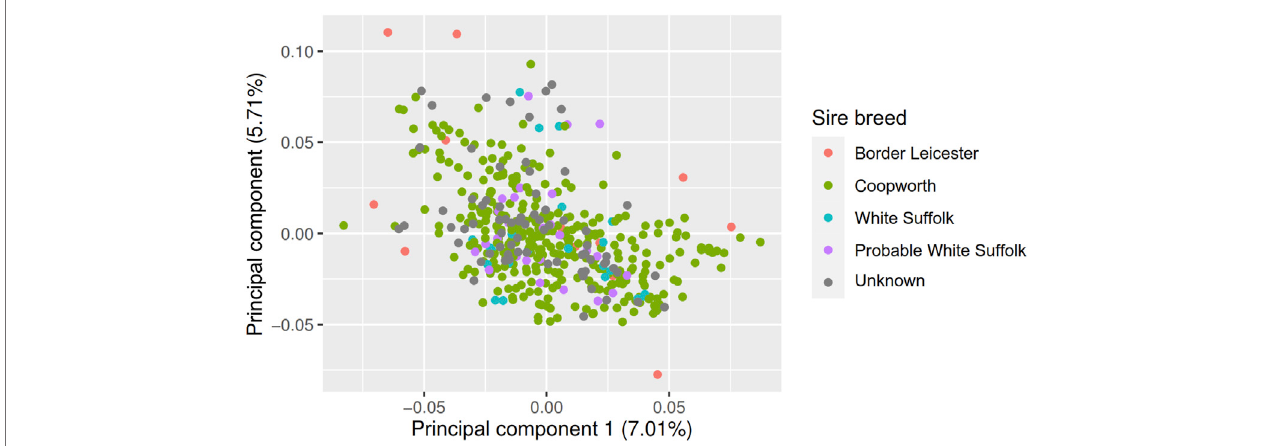
FIGURE 2 | Principal component decompositions of genomic relationship matrix constructed from 38,378 SNP genotypes from post-weaning, hogget, and adult Australian Maternal Composite sheep with two principal components shown (PC1, PC2) and points labelled by sire breed.